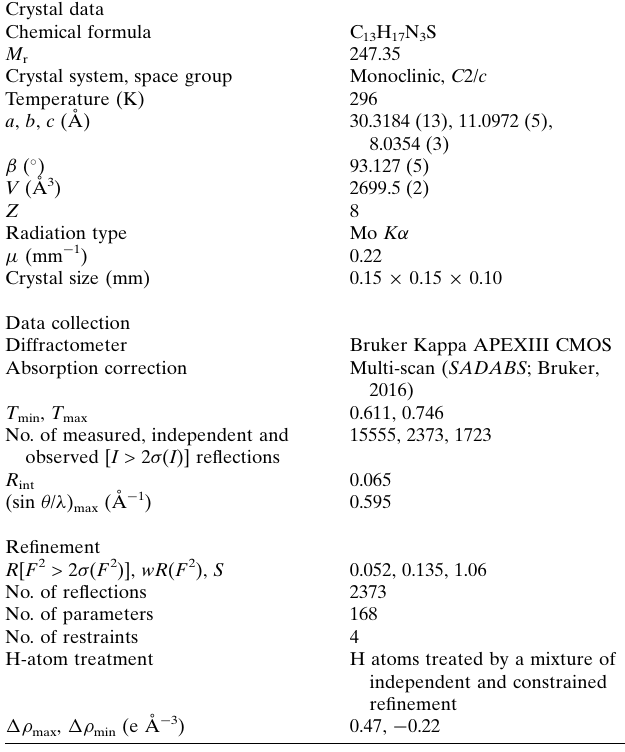
Table 2 Experimental details. Crystal data Chemical formula